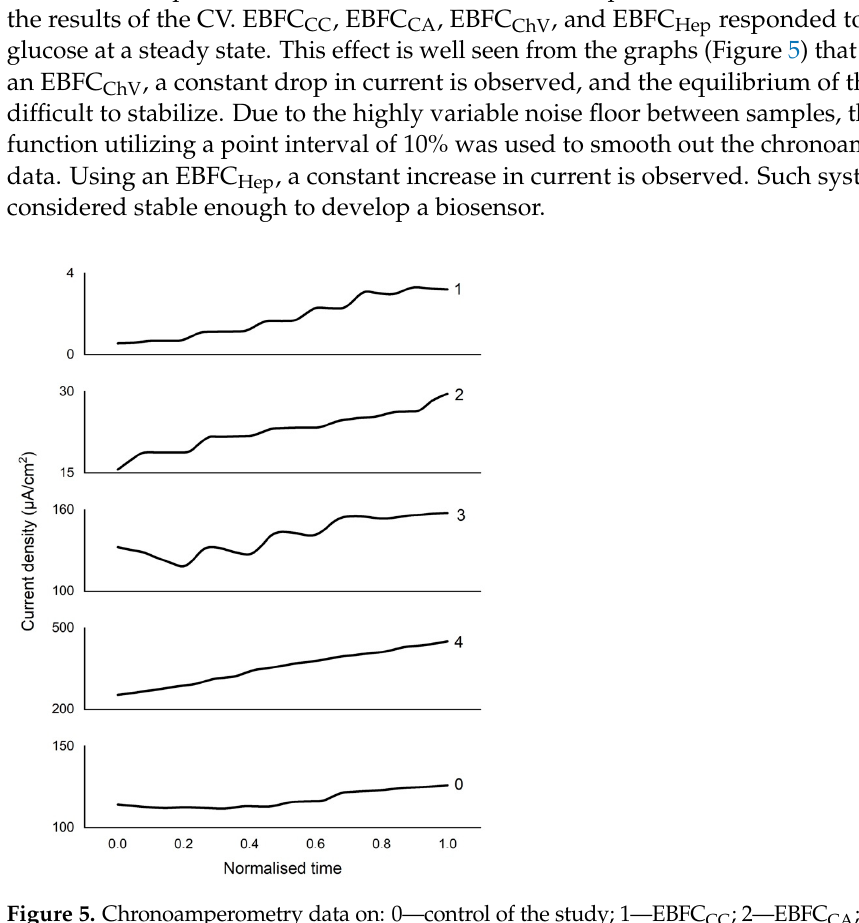
Figure 5. Chronoamperometry data on: 0—control of the study; 1—EBFC CC ; 2—EBFC CA ; 3—EBFC ChV ; and 4—EBFC Hep electrodes. The LOWESS function utilizing a point interval of 10% was used.